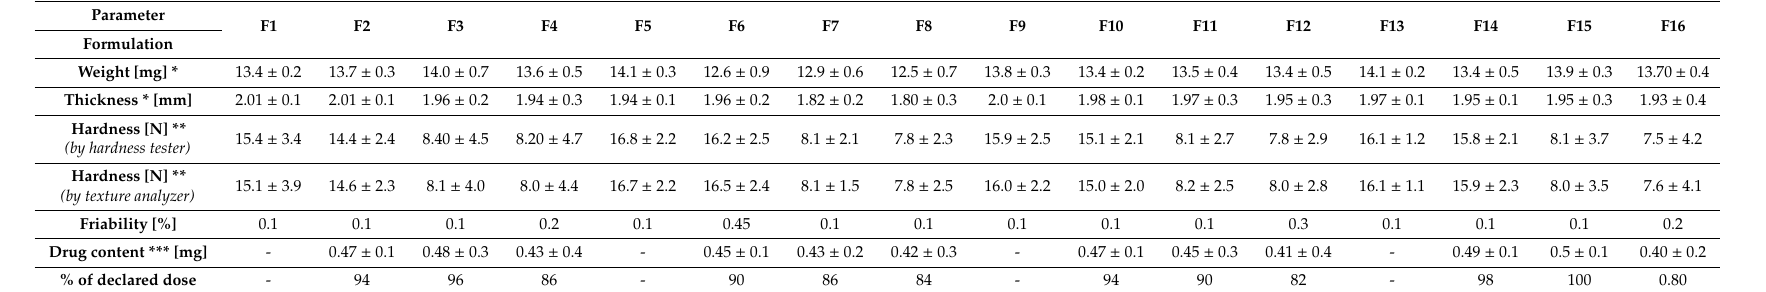
Table 4. Physicochemical characteristics of prepared